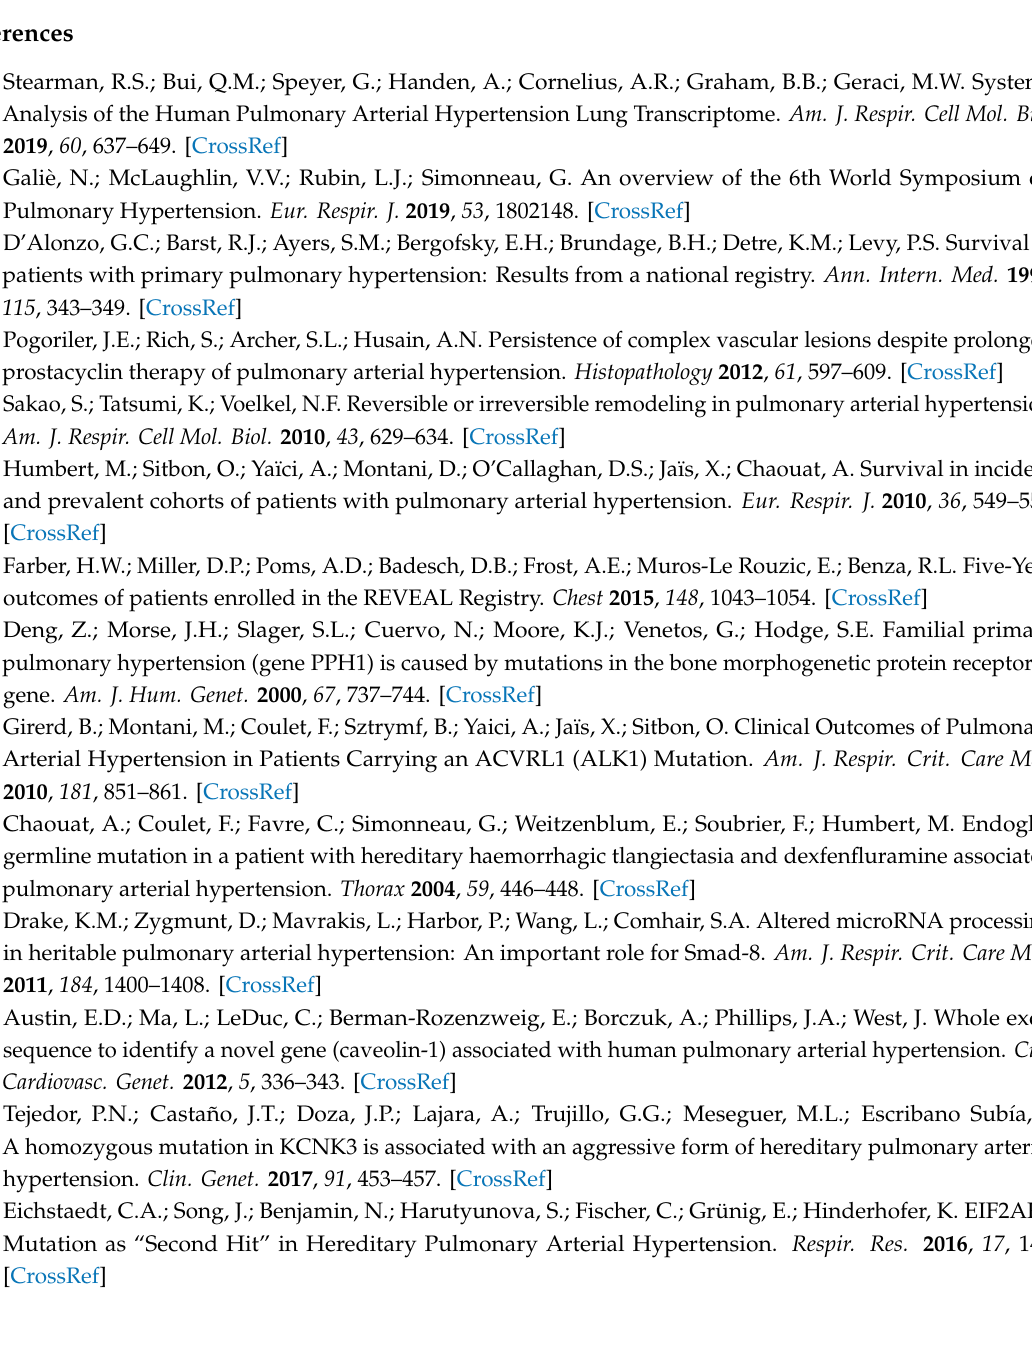
Table S1: Regulation of important genes involved in the immune-inflammatory response; Table S2: Regulation of mitochondrial